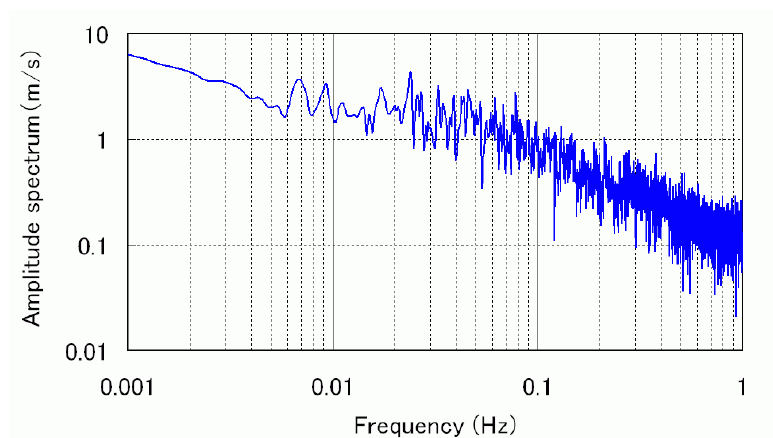
Figure 6 Spectrum analysis result of wind data